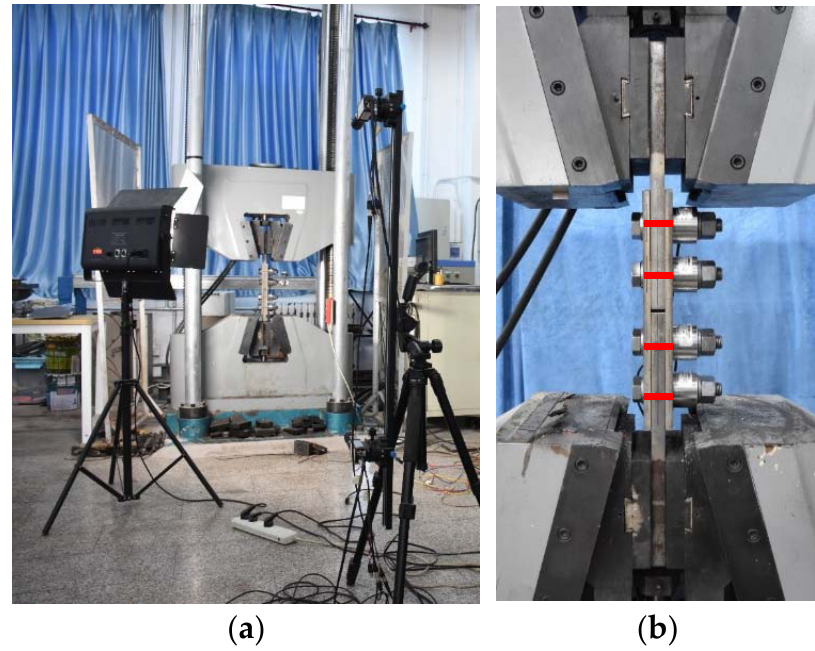
Figure 5. Slip factor test setup. ( a ) Test device and DIC. ( b ) Test specimen.